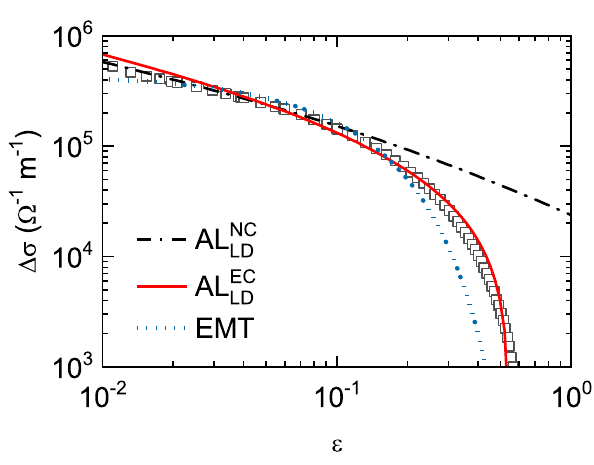
Fig. 2 Excess conductivity data (black squares) compared with LD and EMT approaches: In the case of the LD approach, B LD is the only free parameter. The solid red line was obtained by imposing 𝜀 c = 0.55 in Eq. (2), as predicted in Ref. [20], and leads to B whereas the dot-dashed black line was obtained without a cut- off (imposing 𝜀 c → ∞ in Eq. (2)) and leads to B LD = 0.19 . The best fit to the EMT approach, with both T c and Δ T c as free parameters, is shown as a dotted blue line. While the LD approach with total energy cutoff for the superconducting fluctuation scenario success- fully explains the measurements, the EMT approach for the percola- tive scenario cannot even qualitatively account for our data, mainly in the high reduced temperature